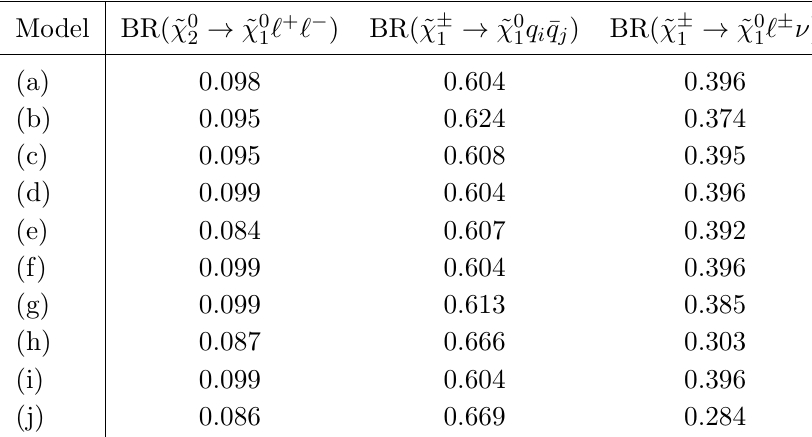
decay and the conjugate of that set for ~ (cid:31) (cid:0) 1